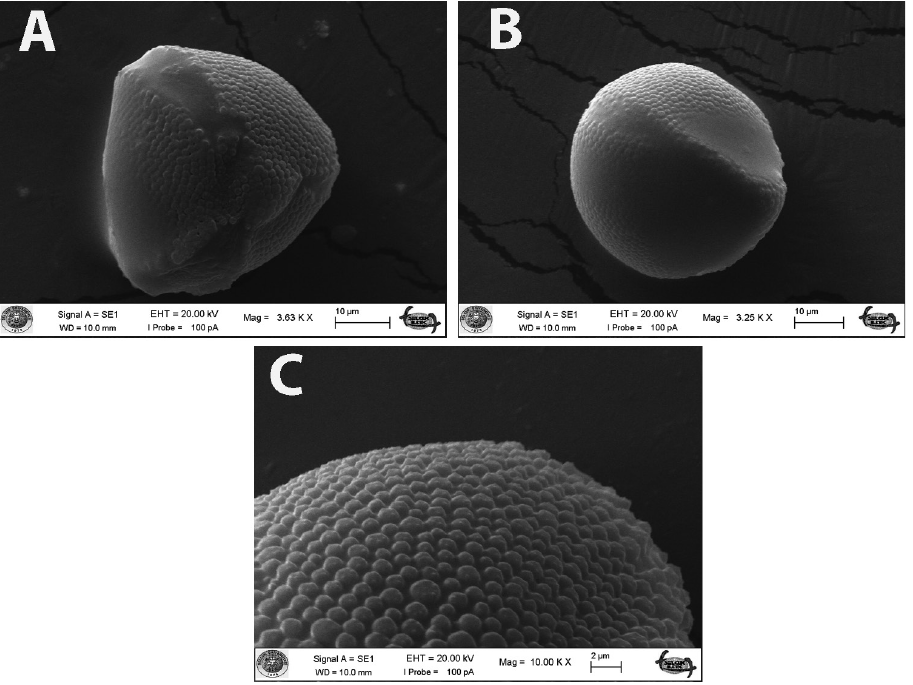
Figure 5. SEM micrographs of the pollen grains of L. aksehirense A–C polar, equatorial view and orna- mentation ( O.Tugay 14.542 & D.Ulukuş